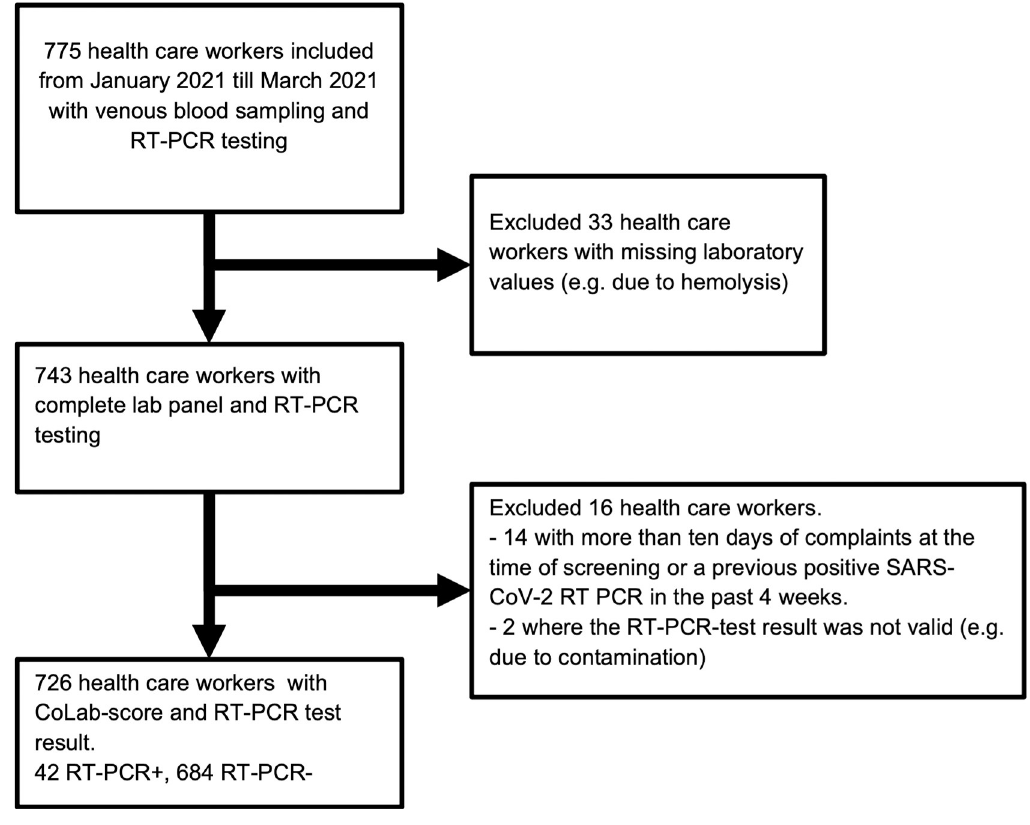
Fig 1. Inclusion